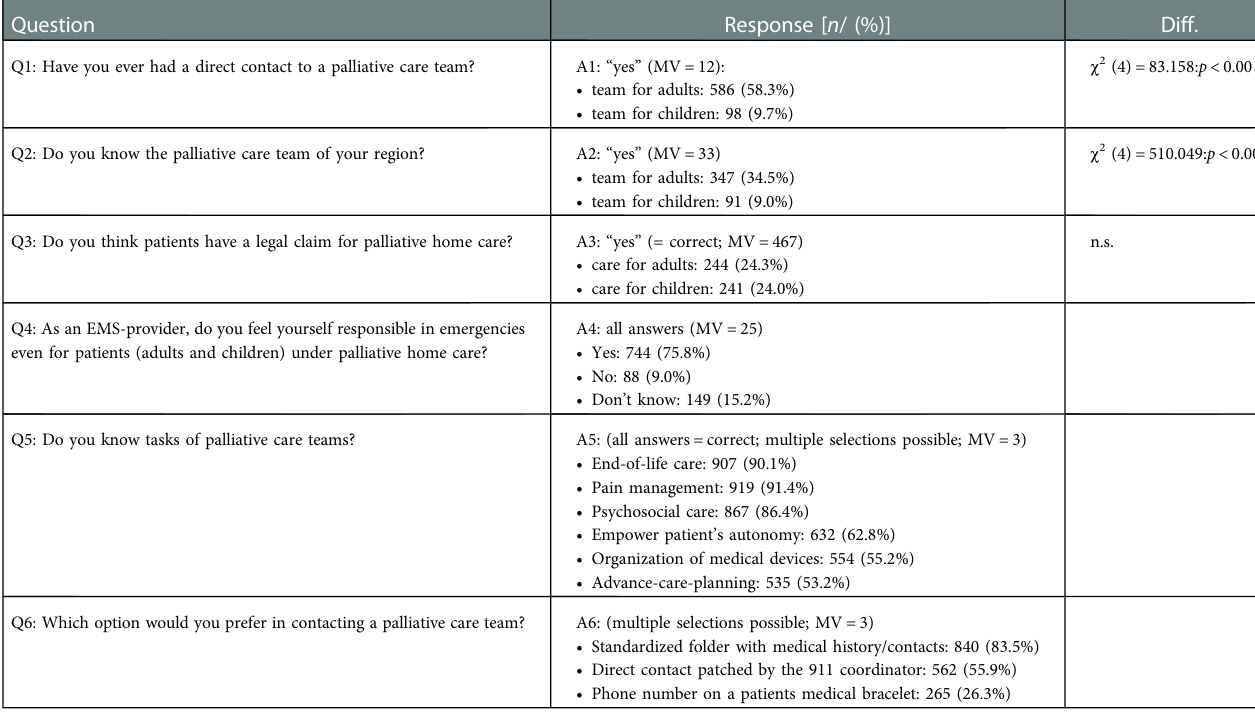
TABLE 3 Experience and knowledge in palliative care. Question